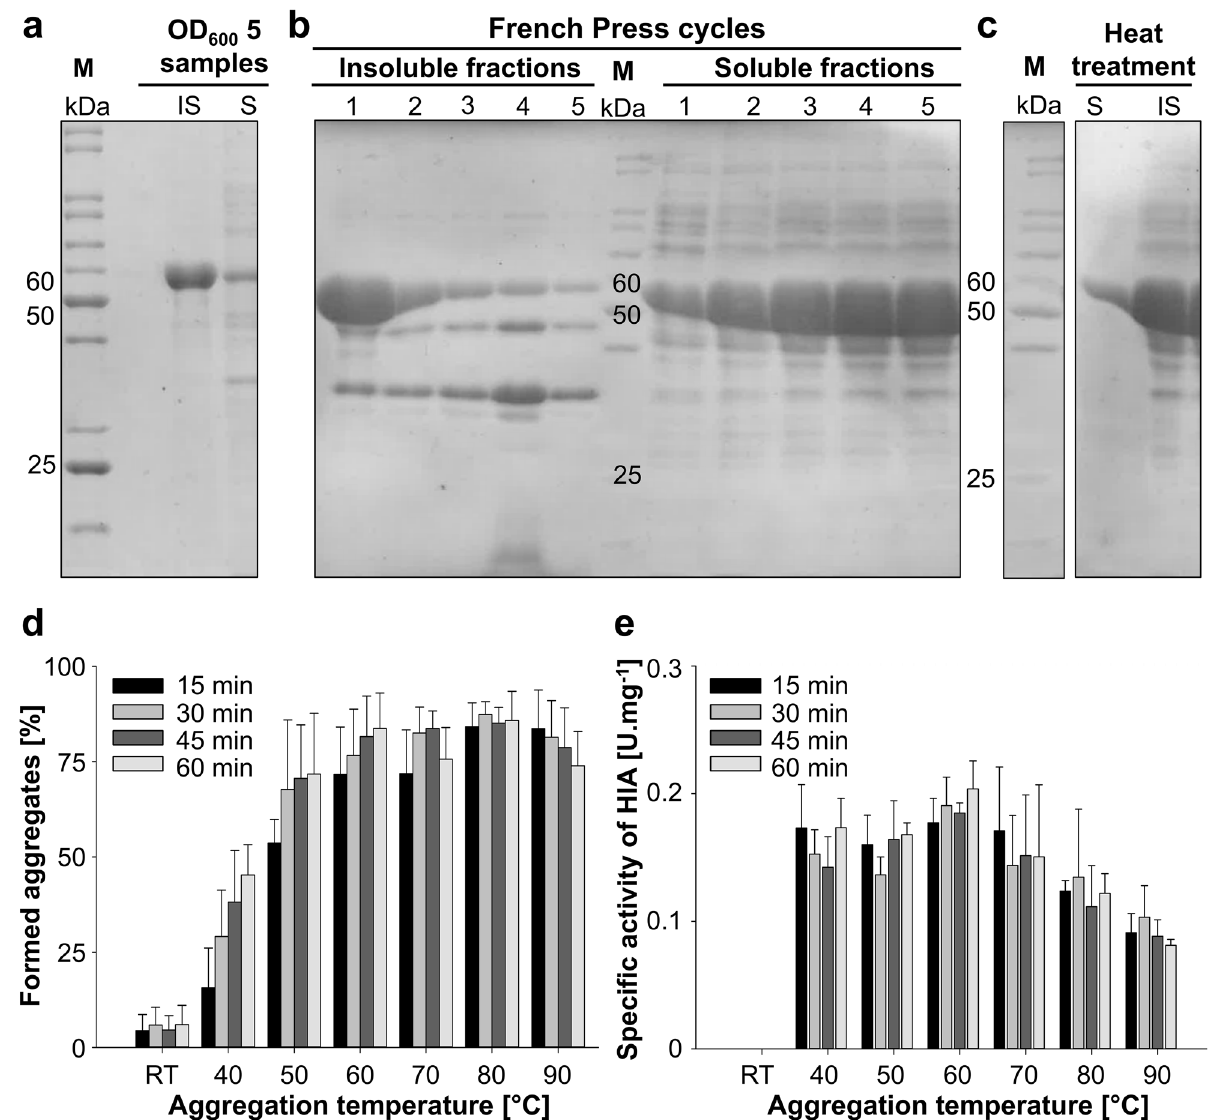
Figure 2. Solubilization and formation of heat-induced aggregates (HIAs) of Tk AMPpase. ( a ) SDS-PAGE analysis of 4 µL both soluble (S) and insoluble (IS) protein fractions of OD 600 = 5 samples after the expression of Tk AMPpase in E. coli using Enpresso B medium. The Tk AMPpase (54 kDa) is mainly detected in the insoluble fraction (IS) after cell disruption using BugBuster Protein Extraction Reagent. M: protein marker. ( b ) 5 µL of the protein fractions obtained from French Press cell disruption at 900 bar analyzed by SDS-PAGE. ( c ) The fifth French Press fraction of the soluble protein was further purified by heat treatment at 80 °C for 30 min which resulted in a significant re-aggregation of the protein and its accumulation in the insoluble fraction. The marker (M) lane and the sample lanes are rearranged from the same gel. The complete SDS-PAGE from ( a ), ( b ) and ( c ) are shown in the supplementary material. ( d ) The induction of aggregation by heat at different temperatures within 1 h. Room temperature (approximately 25 °C) was used as a negative control to examine spontaneous aggregation. Chart is generated based on densitometric analysis of SDS–polyacrylamide gels using ImageJ software. ( e ) The specific activity of all aggregates was determined with 2 mM CMP and 50 mM phosphate in 50 mM MOPS buffer (pH 7.5) at 80